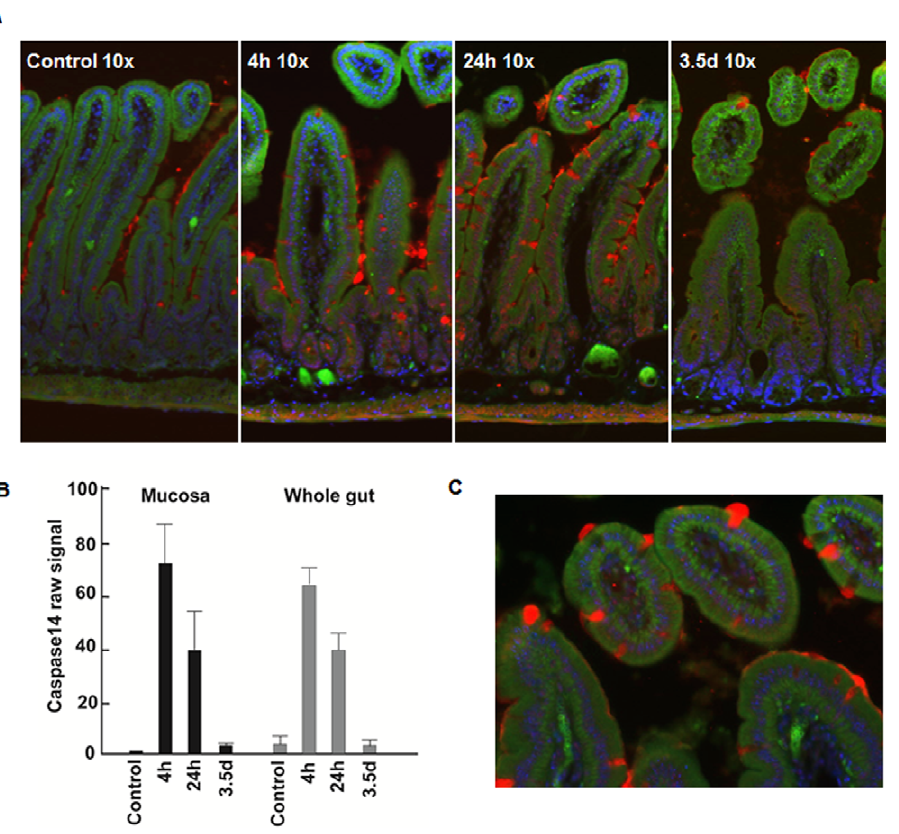
Figure 8. Expression of Caspase14 mRNA and protein in the small intestines. A : Immunohistochemistry demonstrating the expression of Caspase14 in goblet cells in baseline (control) and irradiated intestine at 4 h, 24 h and 3.5 d post irradiation. B : Expression of Caspase14 mRNA in mucosa and whole gut tissue plotted by the raw signal from microarray. C : A higher magnification power demonstrating goblet cells secreting Caspase14 at 24 h post irradiation. Red: Caspase14; Green: E-cadherin; Blue: DAPI.